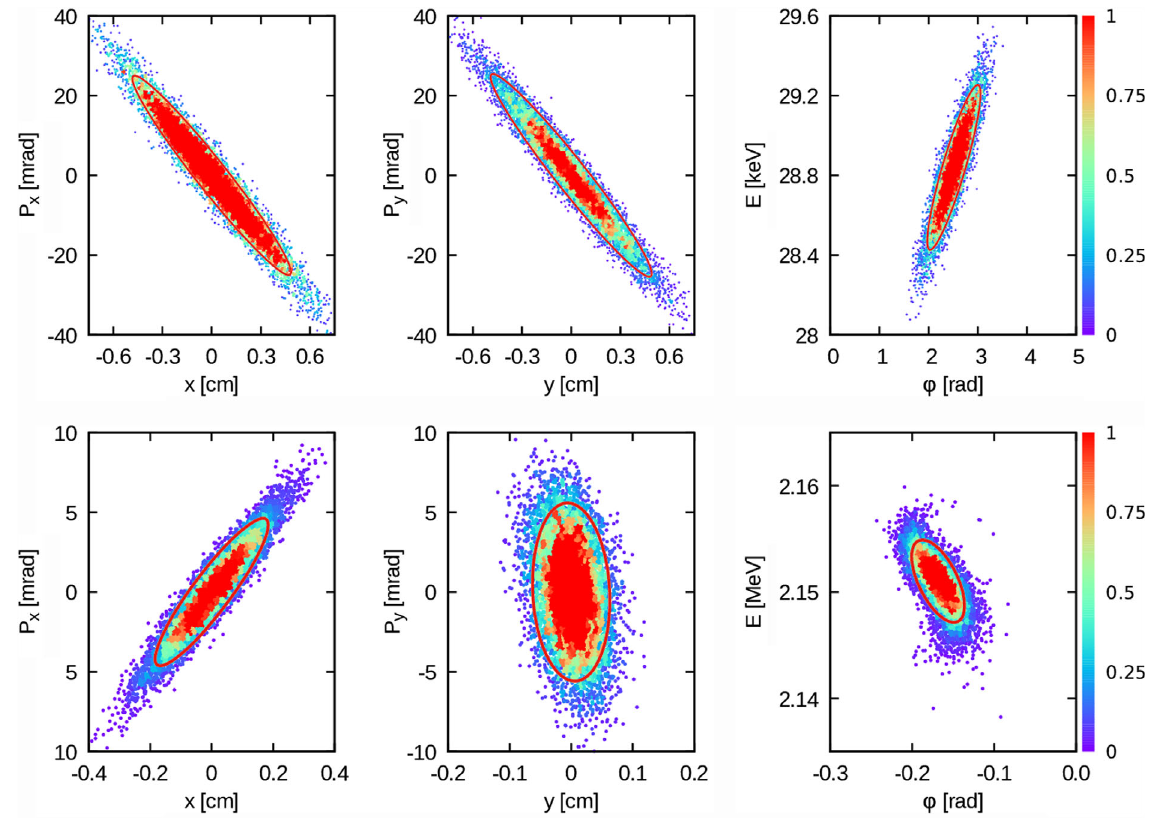
FIG. 4. PARMTEQ normalized particle density distribution overlaid with TRANSOPTR ellipse of area 4 πϵ containment for Gaussian distributed beam. Input distributions in x - P input and output locations are defined at the outer edges of the RFQ vacuum tank, 16.86 cm before and 15.83 cm after the RFQ vanes, respectively.